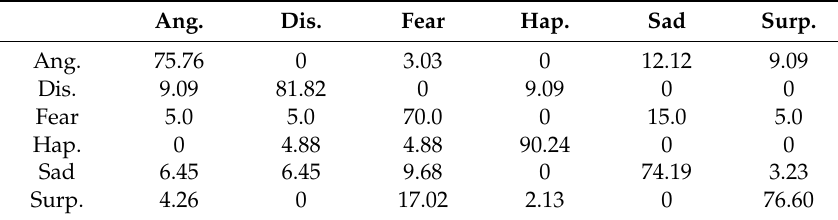
Table 8. The confusion matrix of VSHNN with FS module for MMI dataset.